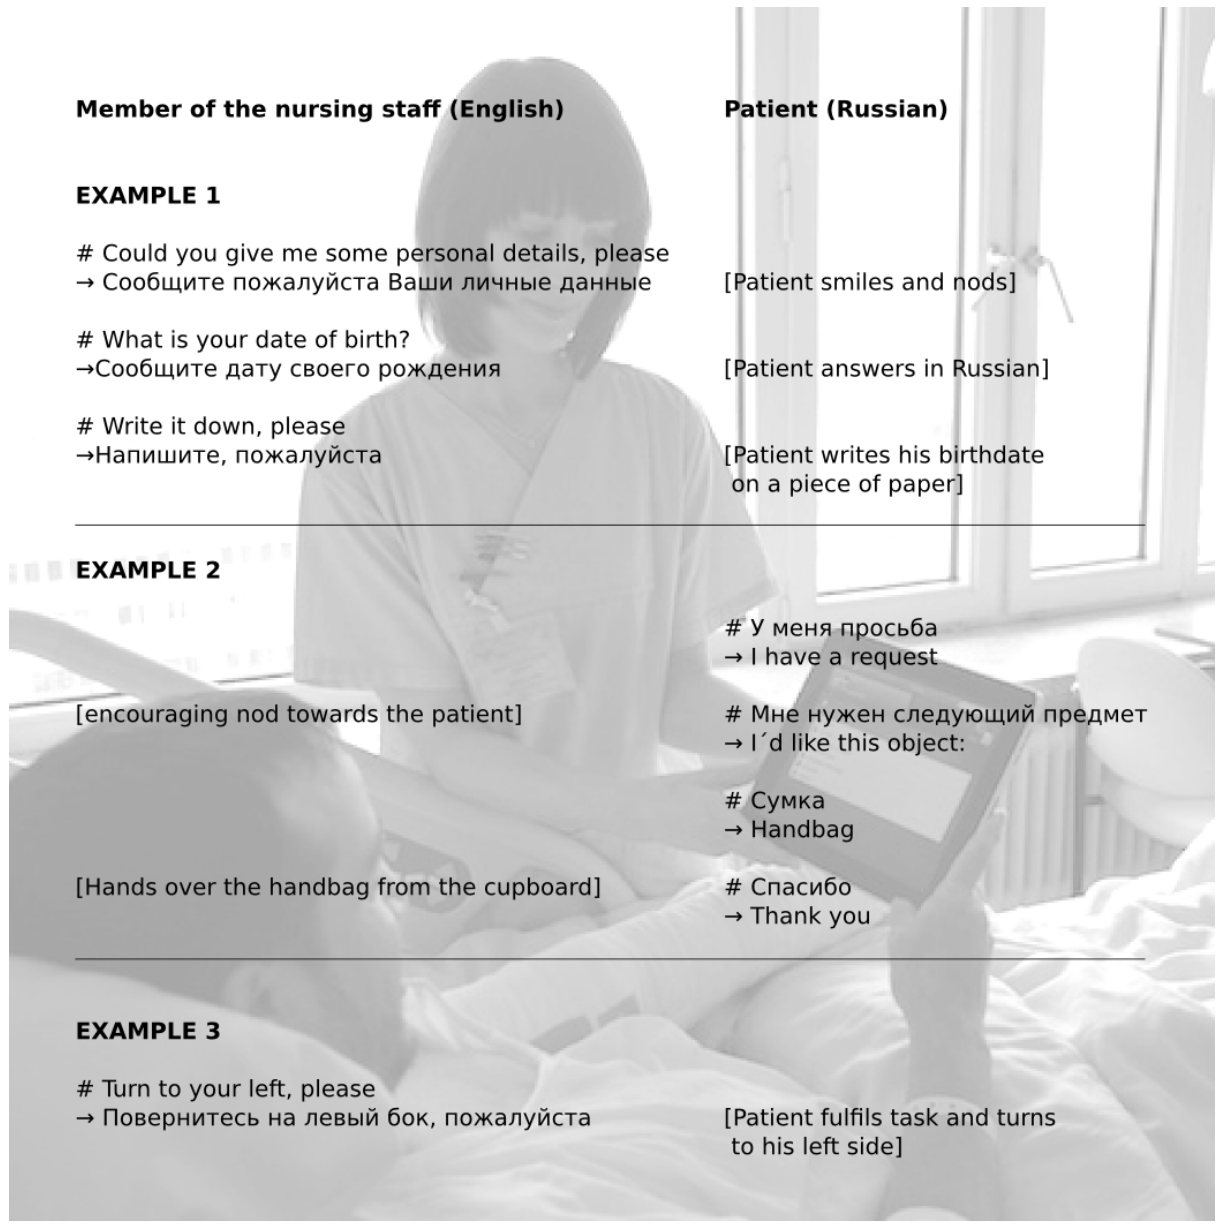
Figure 1. Three examples for basic communication between nurses (left) and patients (right) based on the phrases integrated into xprompt. “#” indicates the phrase chosen in the application, and “ → ” the corresponding translation. Notes in “[ ]” describe the reactions of the